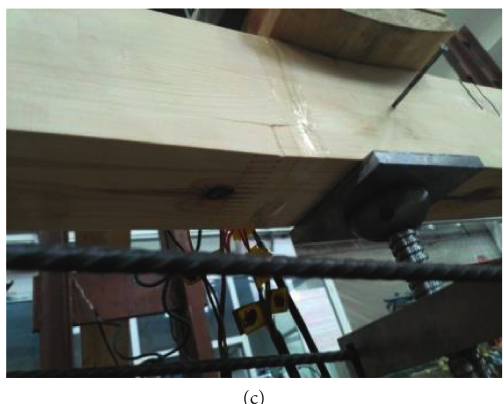
Figure 7: Cracks at the bottom of the Glulam beam. (a) Cracks at the bottom of the L span. (c) Cracks at the bottom of the L A7(2) right span.